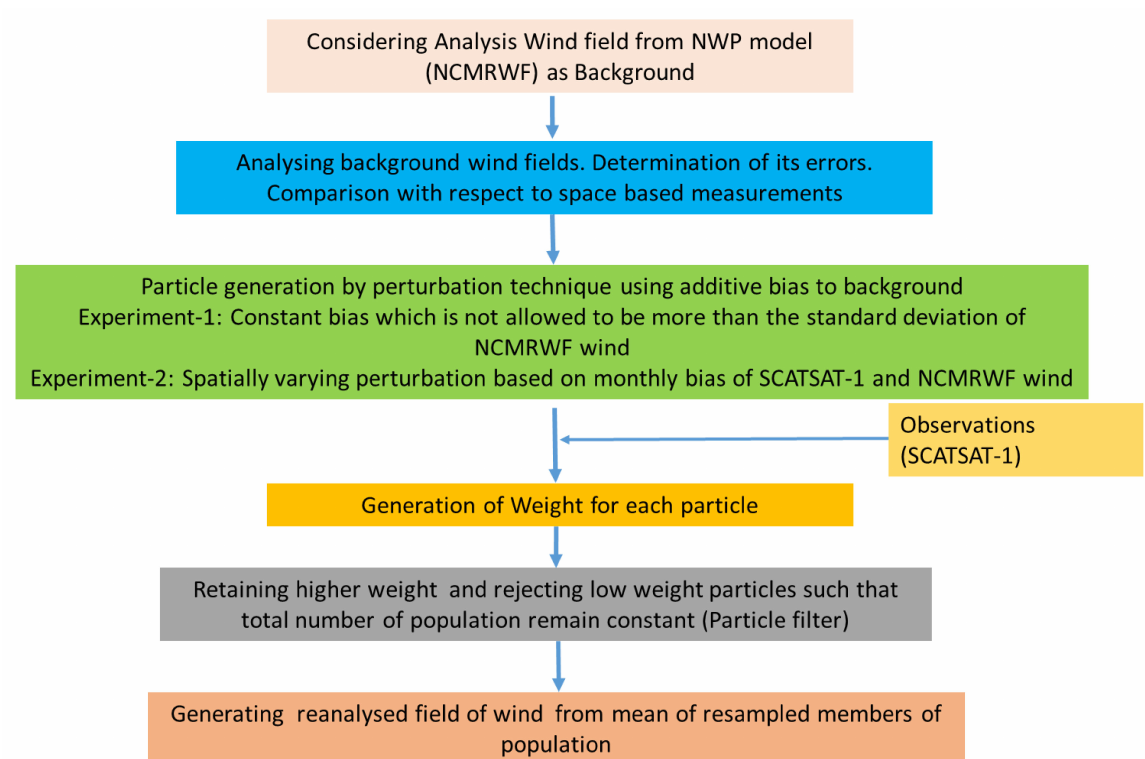
Figure 2. Particle-filter implementation